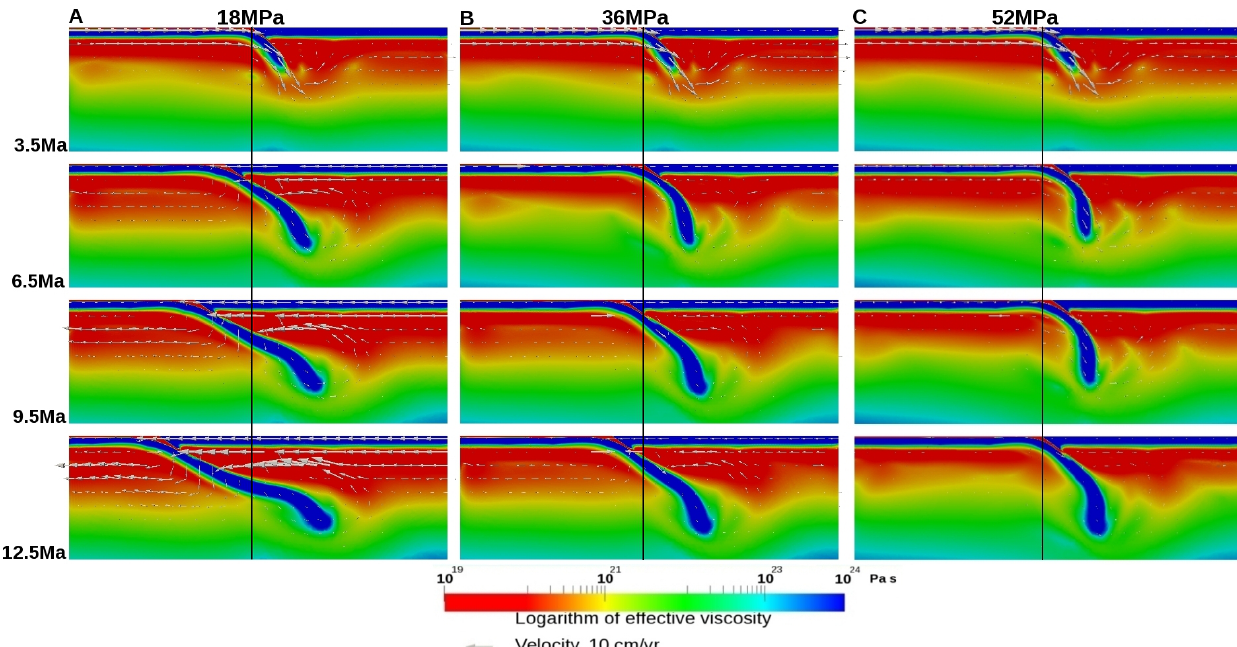
Fig. 10. The evolution of the models with open boundary conditions with different intraplate stress values on the overriding plate: (A) model with intraplate stress 18MPa; (B) model with intraplate stress 36MPa; (C) model with intraplate stress 52MPa. Vertical black lines represent the initial trench